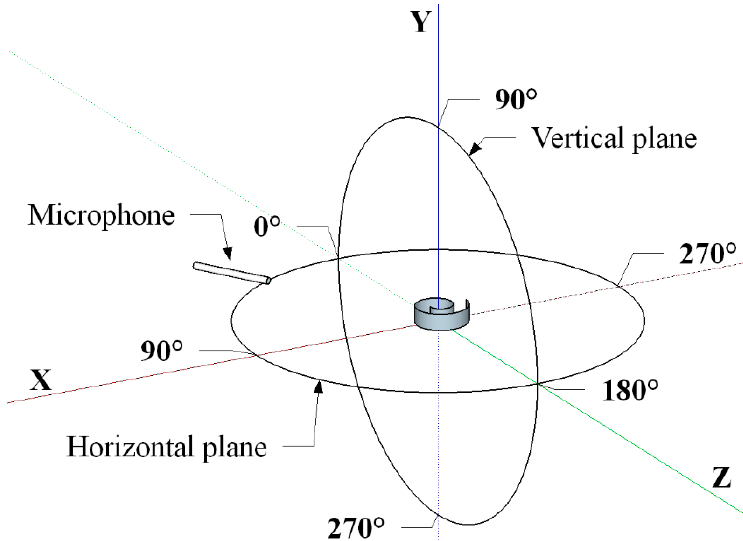
Figure 5. Experimental setup (not to scale) to measure the transmitted radiation pattern in both the horizontal and vertical plane. The distance separating the microphone, which can be manually moved with 15° steps, and the ultrasounds (US) transmitter, was equal to 0.3 m.